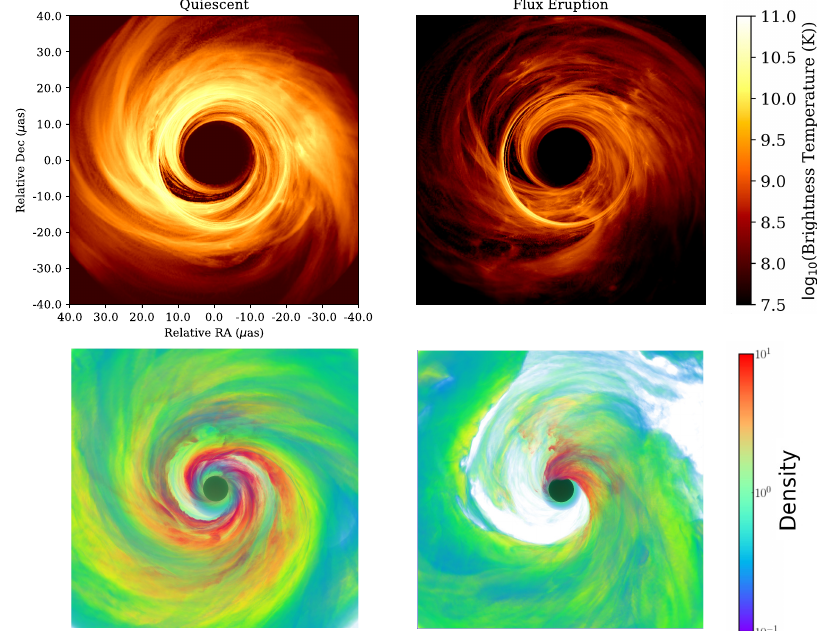
Figure 1. Magnetic flux eruptions can remove over half of the disk from near the black hole, signifi- cantly changing the resultant horizon-scale image. Top : Snapshots of simulation in quiescent state ( left ) and flux eruption event ( right ), ray-traced with equal mass scale units at a viewing inclination of 17 ◦ . Bottom : 3D rendering of gas density (in GRMHD code units) for the quiescent state ( left ) and flux eruption event ( right ) within the inner 15 M, viewed at 17 ◦ . The white region in the density plot shows the evacuation of the disk and the formation of a low density magnetospheric region near the black